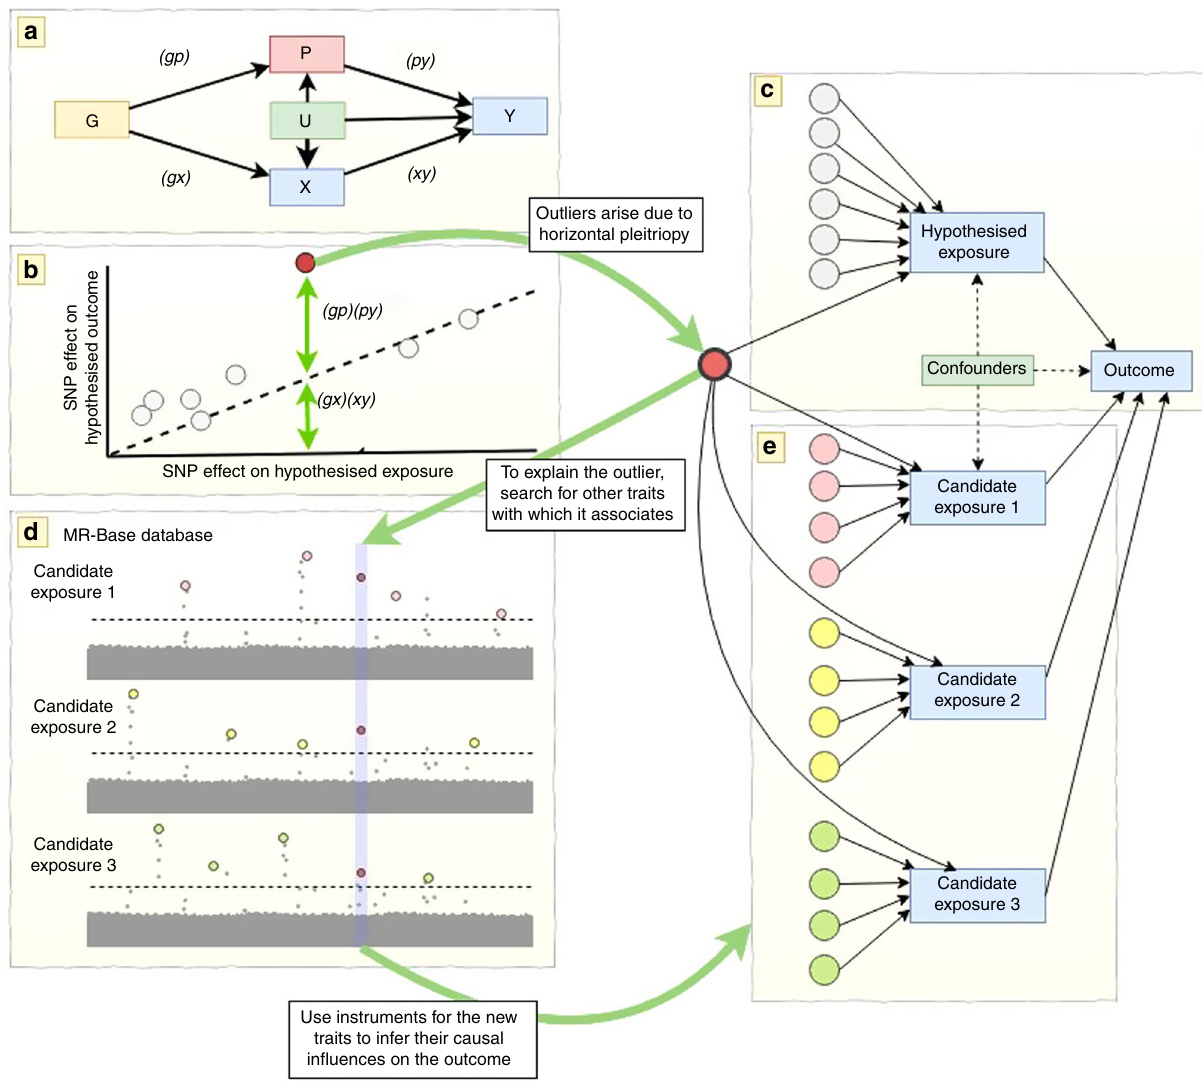
Fig. 1 Conceptual framework of the study. Illustration of identifying putative factors that in fl uence the original observations. a Where ( gx ) is the SNP – exposure effect, ( xy ) is the exposure – outcome effect as estimated through MR analysis from the non-outlier SNPs, ( gp ) is the SNP – candidate trait effect and ( py ) is the causal effect of the candidate trait on the outcome. b The open circles represent valid instruments and the slope of the dotted line represents the causal effect estimate of the exposure on the outcome. The closed red circle represents an outlier SNP which in fl uences the outcome through two independent pathways, P and X. c One way in which the red SNP can exhibit a larger in fl uence on the outcome than expected given its effect on the exposure is if it in fl uences the outcome additionally through another pathway (horizontal pleiotropy). d Using the MR-Base database of